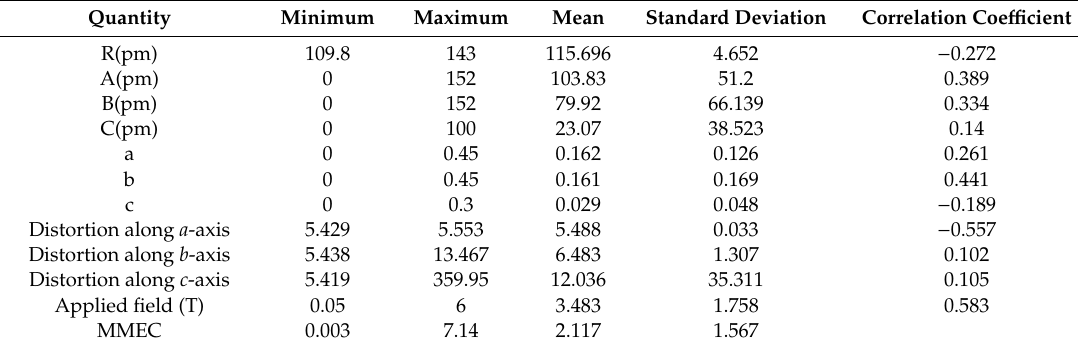
Table 1. Statistical analysis of the